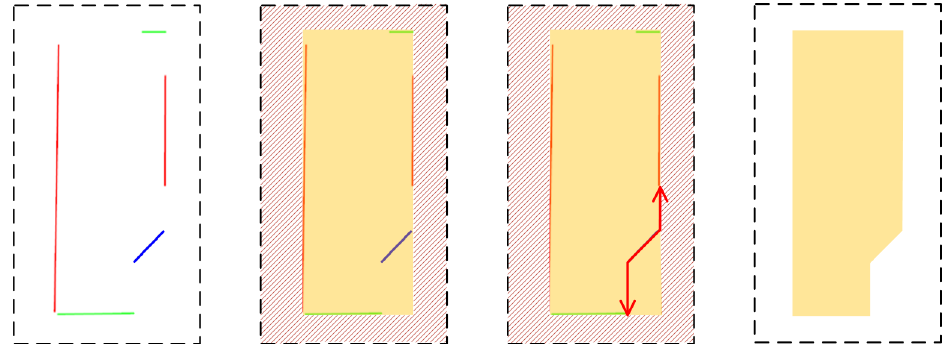
Figure 16. Arbitrary primitive processing: Linkage and cutting (the blue line indicates the set of type III primitive— L b ).